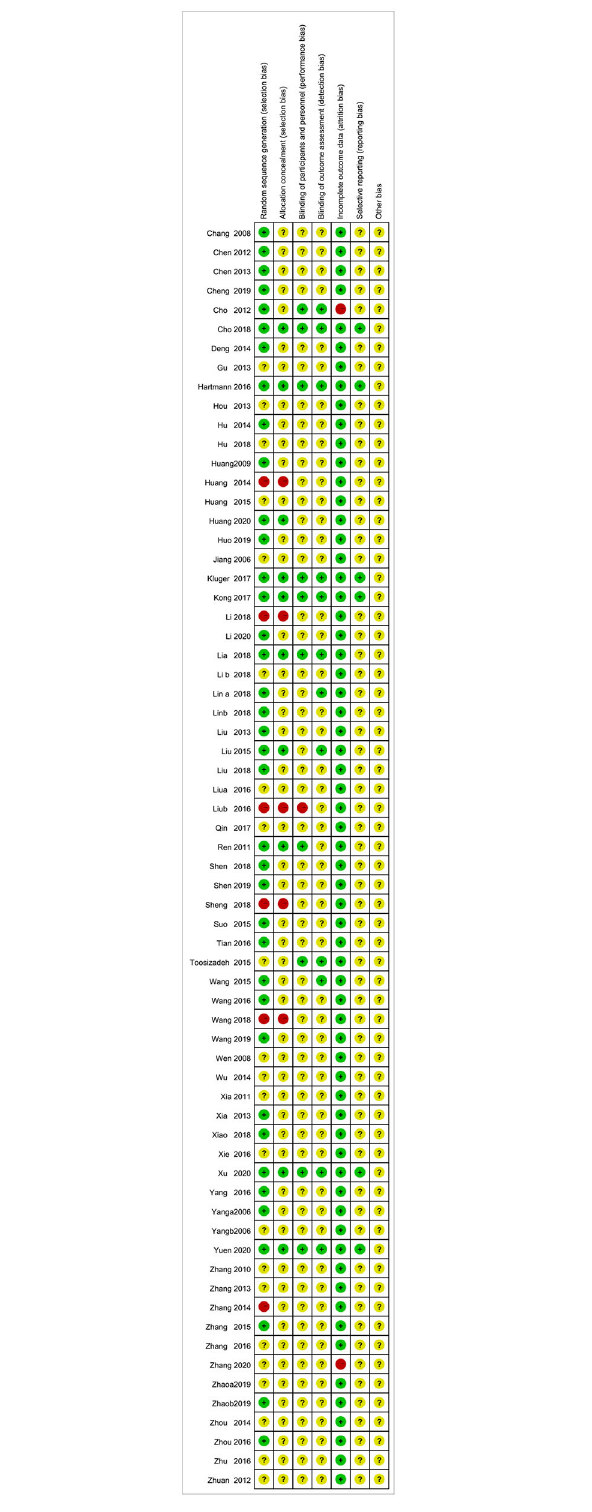
FIGURE 3 | Risk of bias summary: review authors’ judgements about each risk of bias item for each included